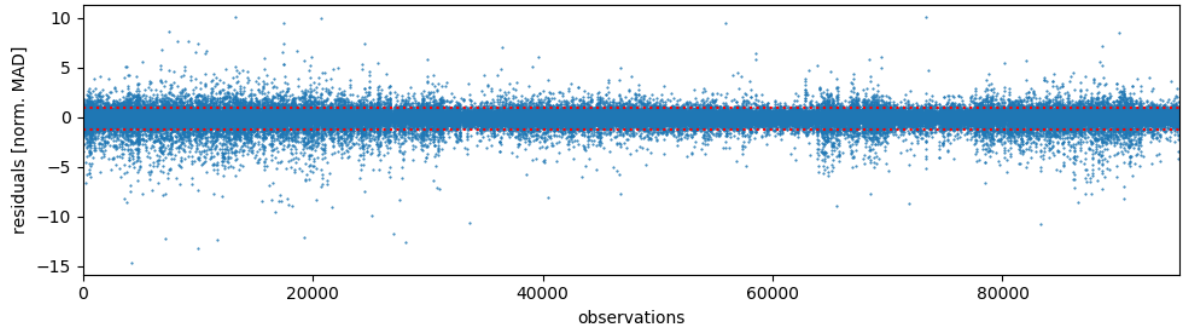
Figure 4. Plotted observation residuals (blue) with 5- and 95-percentiles (red).